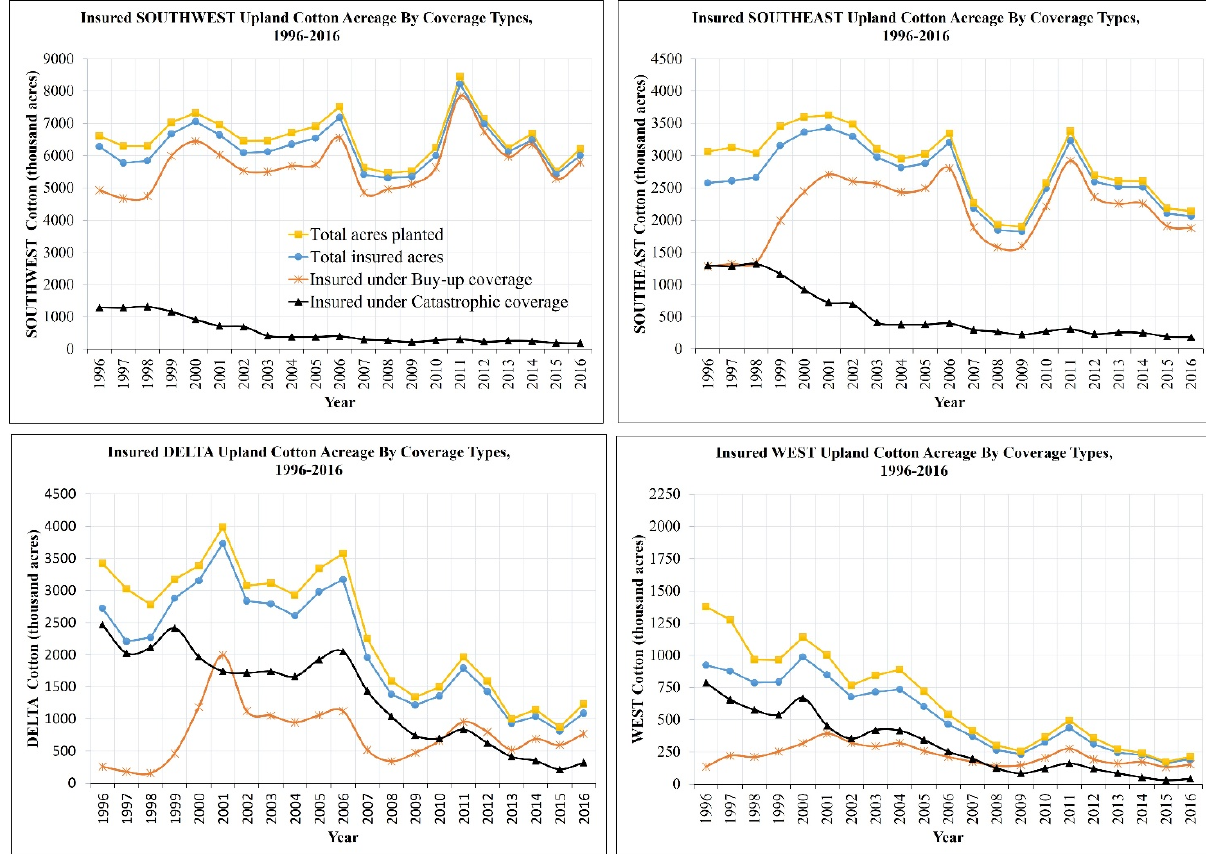
Figure 3. Insured US upland cotton acreage by coverage level and region, 1996–2016.